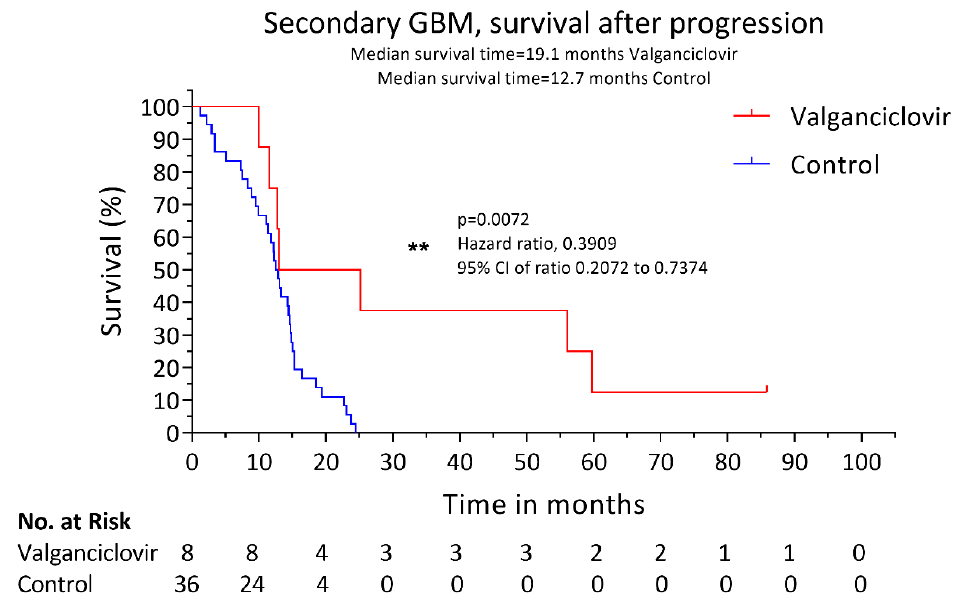
Figure 1. Kaplan–Meier estimates of median overall survival (OS) after progression. Estimated median OS after progression to glioblastoma for 8 patients with secondary glioblastoma who received valganciclovir therapy (red) and for 36 contemporary controls who received similar second-line therapy (blue). **: the level of significance of the p value ( p = 0.0072) indicated with the symbol ** by the statistical program used, Graphpad v. 8.